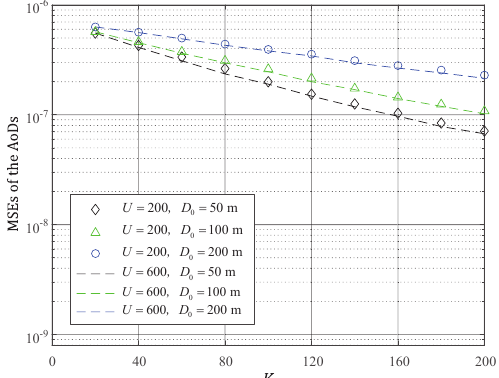
Figure 3. MSEs of the AoD estimations in the WSSUS channel models for V2V communications with respect to the distance D 0 when v T = 10 m/s, v R = 10 m/s, ϕ T = π , and ϕ R =